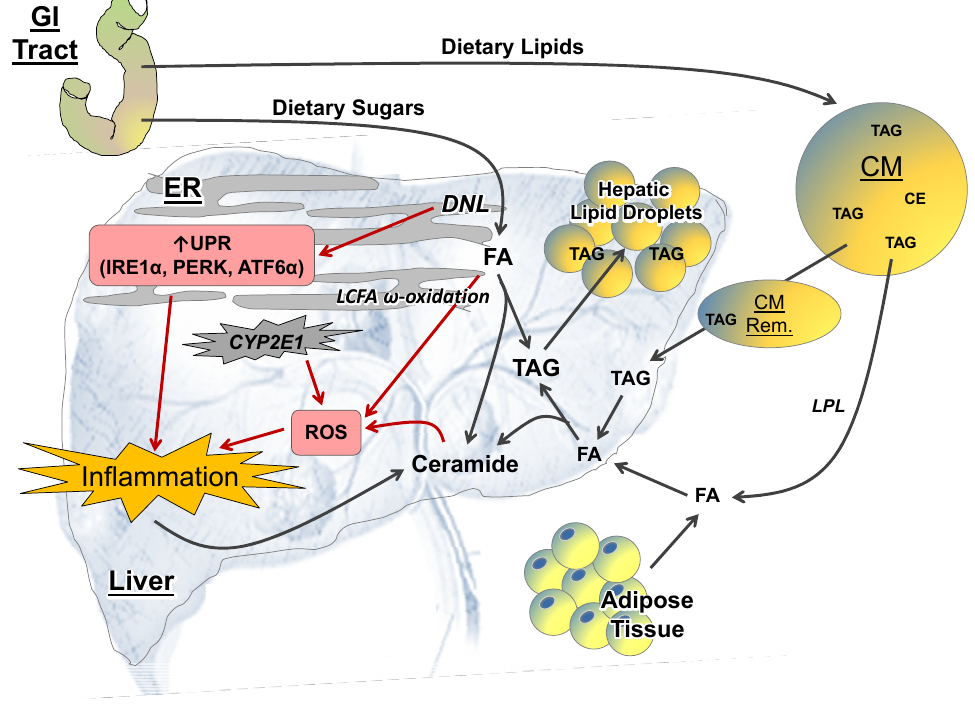
Figure 2. Mechanisms of intra-hepatic perturbations in non-alcoholic fatty liver disease (NAFLD) progression. Increase in dietary lipids elevates triglyceride (TAG) and cholesterol delivery to the liver by chylomicrons (CM) and CM remnants (Rem.). Excess TAG